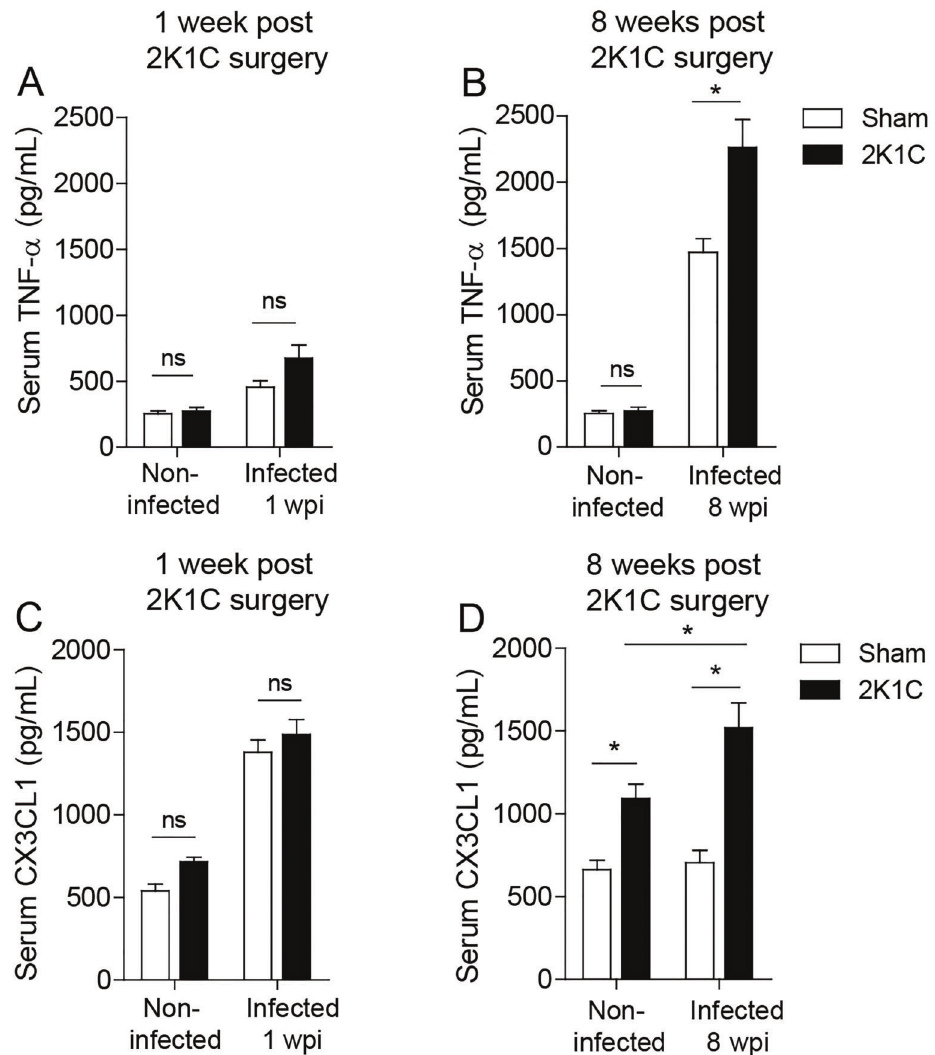
Figure 3. Serum TNF and CX3CL1 in infected two-kidney one-clip (2K1C) rats. One and 8 weeks after 2K1C (n=8) or Sham (n=8) surgery, immediately followed, or not, by infection with 1.2 (cid:1) 10 6 trypomastigote forms of the Y strain of T. cruzi , the serum levels of TNF ( A and B ) and CX3CL1/Fractalkine ( C and D ) were measured by ELISA assay. Data are reported as means ± SE. *P o 0.05, one-way ANOVA followed by Bonferroni post-test. ns: non-signi fi cant difference. wpi: weeks